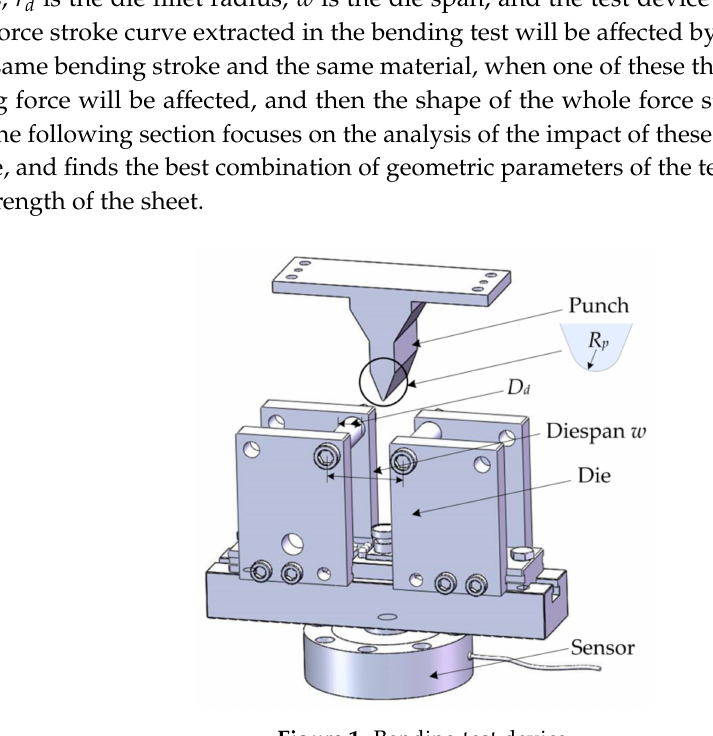
Figure 1. Bending test